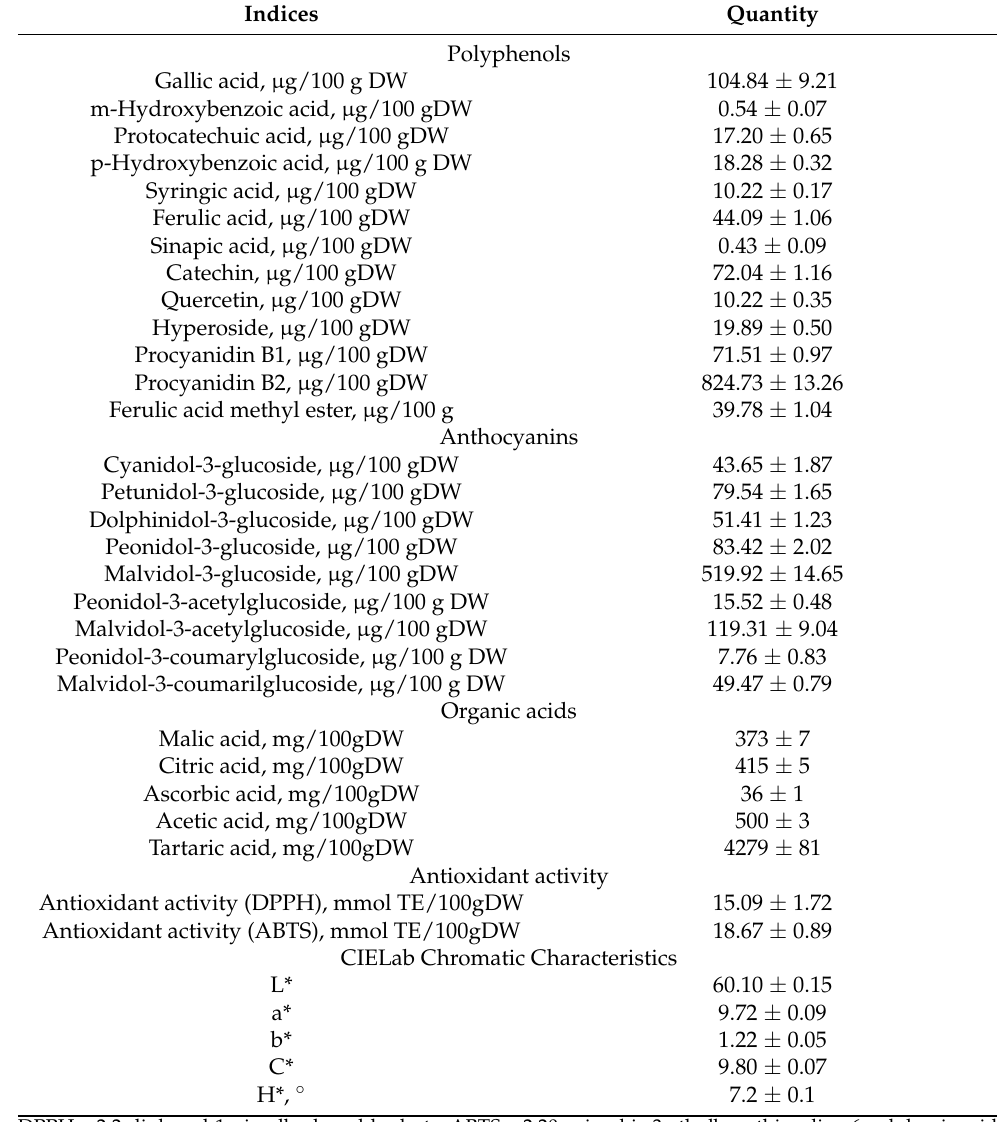
Table 2. Polyphenols, anthocyanins and individual organic acids, antioxidant activity and CIELab color parameters in grape marc hydroethanolic extract at 60% ( v / v ) and extraction temperature of 65 ◦ C (the results are expressed as means ± standard deviations of three